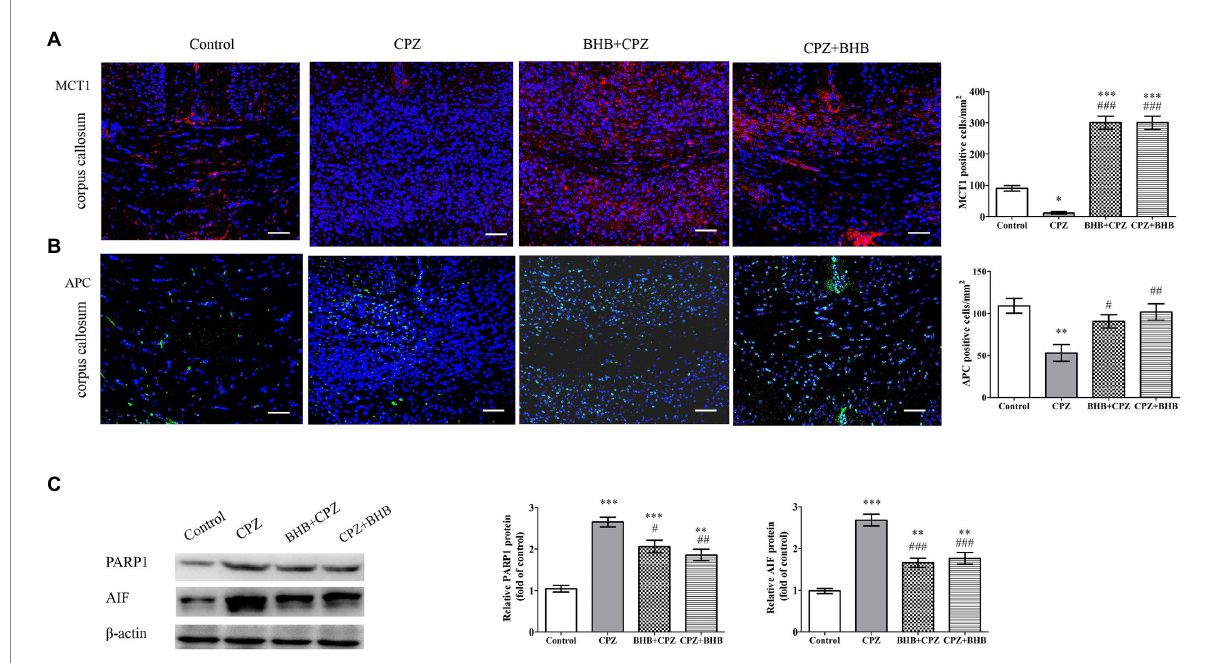
FIGURE 7 Expression of MCT1 and APC, and PARP1 and AIF in the corpus callosum of CPZ-fed mice. The immunofluorescent staining and intensity quantification of MCT1 (A) and APC (B) in the corpus callosum of mice in different groups. (C) WB assays (PARP1, AIF and β -actin as a loading control). Scale bars = 50 μ m. Data are presented as mean ± SEM. N = 3 per experimental group; experiment repeated two times. * p < 0.05, ** p < 0.01, and *** p < 0.001 versus the control group; # p < 0.05, ## p < 0.01, and ### p < 0.001 versus the CPZ